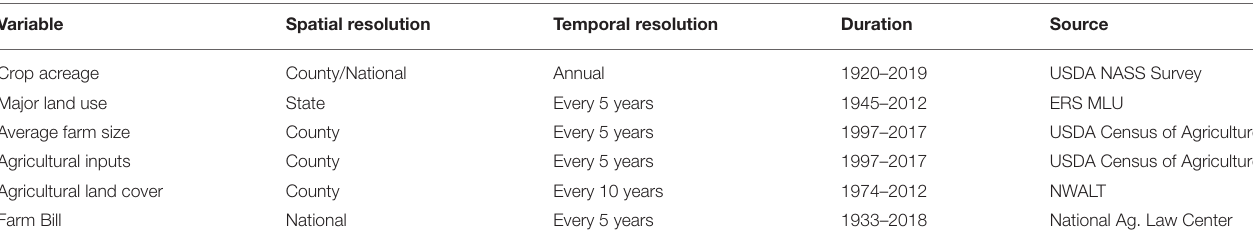
TABLE 1 | Datasets used to visualize crop composition, acreage, productivity, and policy changes.